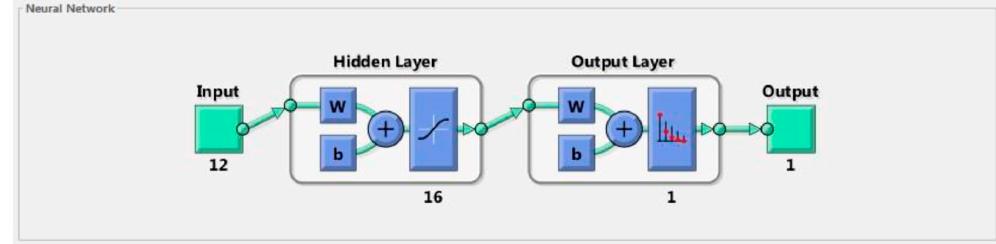
Figure 7. General structure of the applied using neural network polynomial coefficients with the degree N = 3.